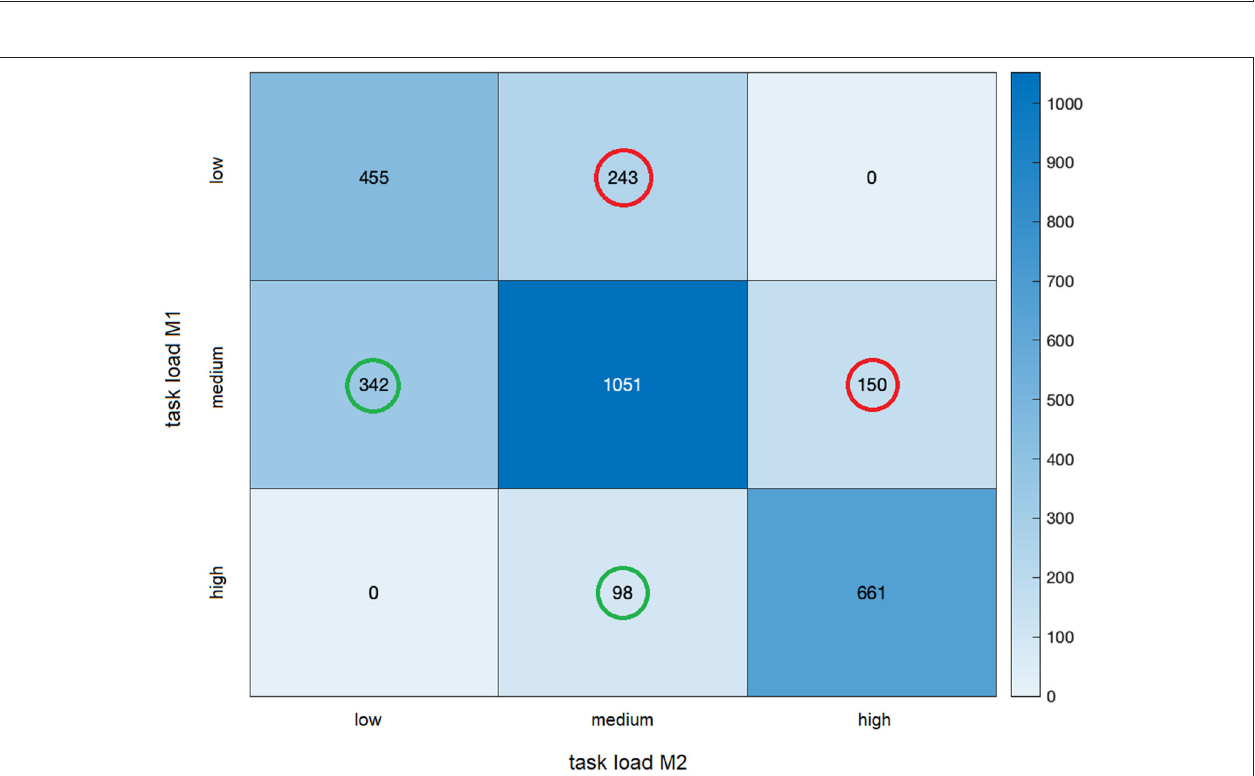
FIGURE 8 | Heatmap of EEG-based estimation of task load at MP1 and MP2. The figure shows the number of road sections that were rated as equally difficult at both measurement times, as well as the number of sections that were rated as easier (outlined in green) or more difficult (outlined in red) in MP2 than in MP1, averaged across all participants. A total of 3,000 (10-meter) track segments were classified as of low, medium, or high task load.